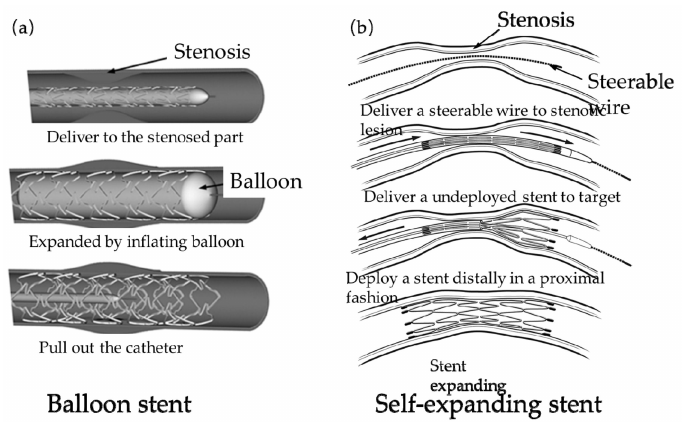
Figure 2. Two expansion forms of vascular stents: ( a ) Balloon stent [23]; ( b ) Self-expanding stent